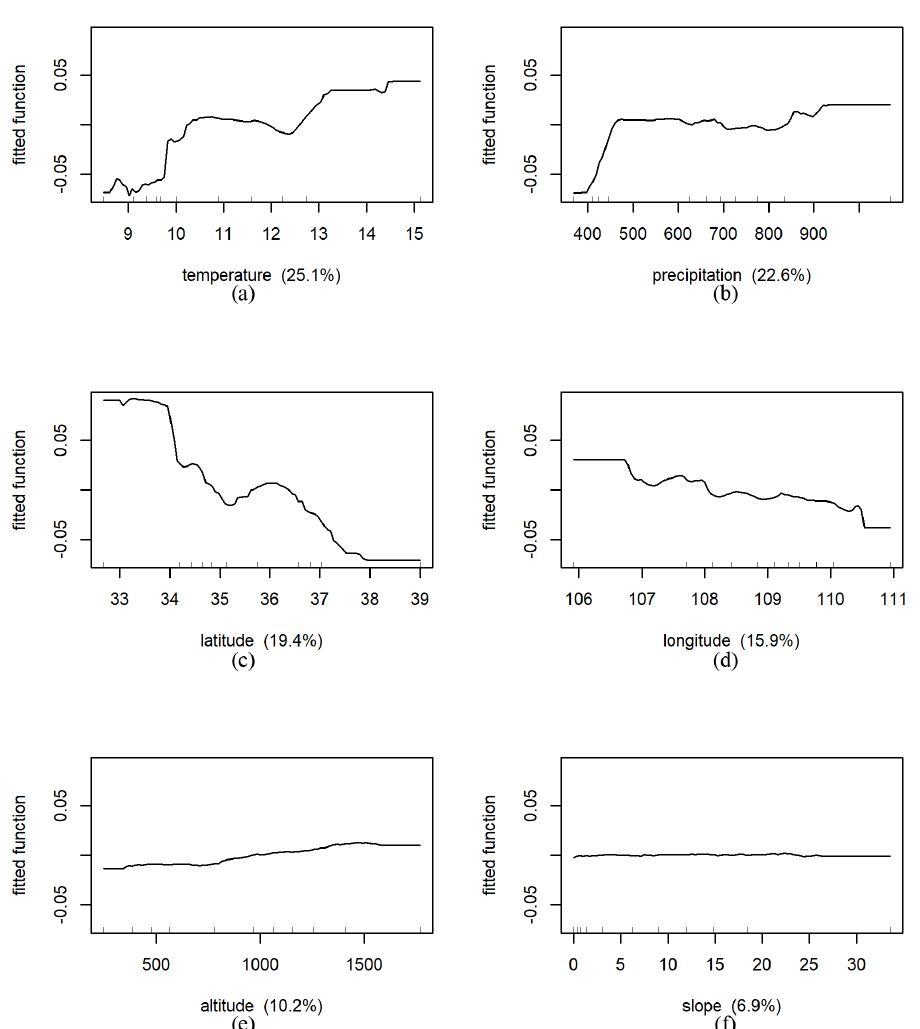
Figure 18. Results of marginal effects of environmental factors on NDVI under cropland in whole Shaanxi Province (The fitted function of NDVI vs. ( a ): temperature (°C), ( b ): precipitation (mm), ( c ): latitude (N), ( d ): longitude (E), ( e ): altitude (m), ( f ): slope (°), respectively. The x -axis denotes the predictive variable; the contents in brackets in the title of the x -axis represent relative influence. The y -axis denotes the marginal effect of the selected variables by “integrating” out the other variables).